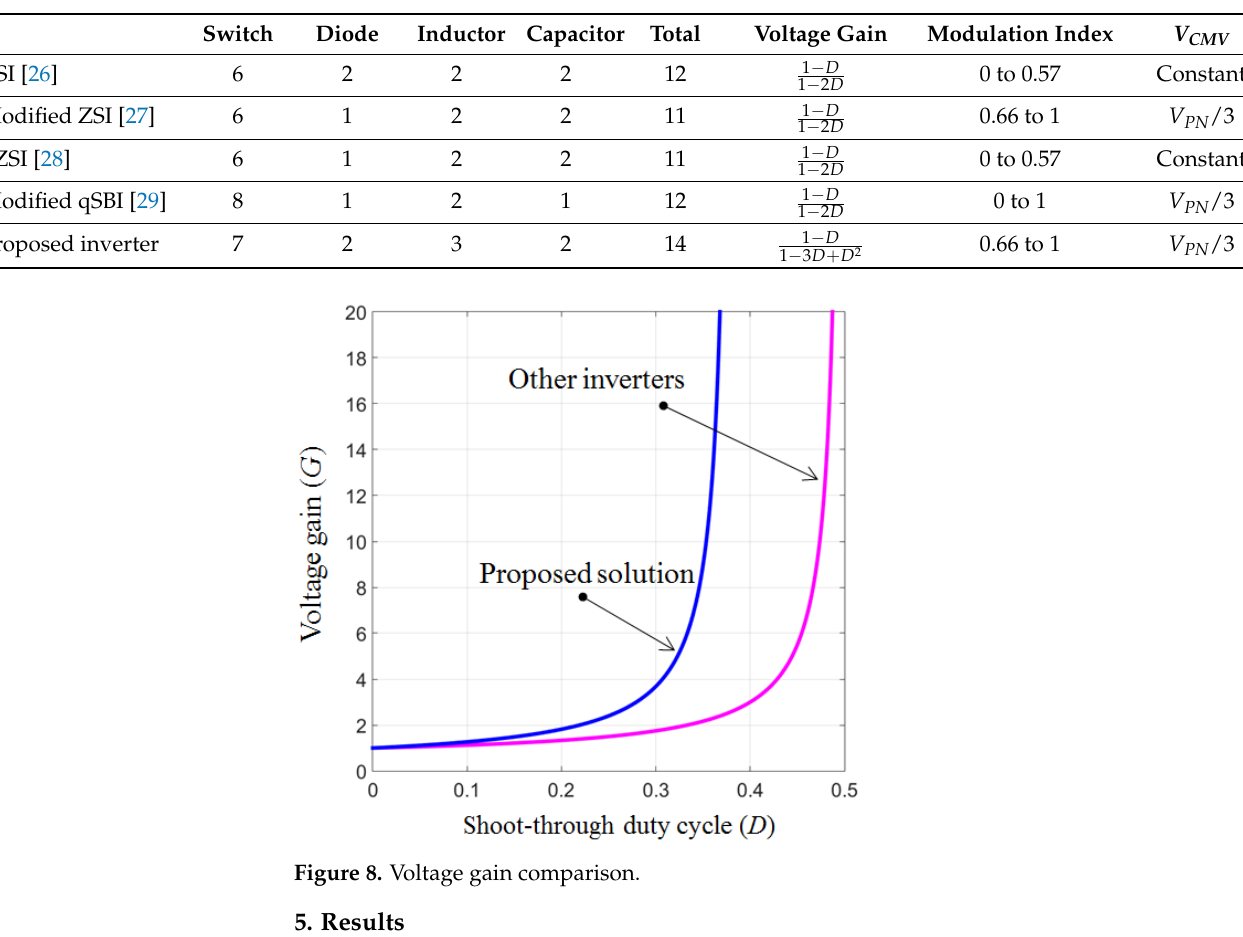
Table 4. Parameters of the MAqZSI.